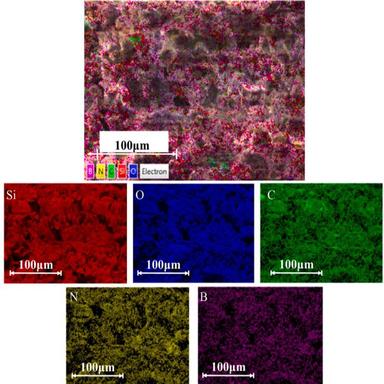
EDS images of BNNT-SiCN material. Nanoparticles are colored based on atomic composition.